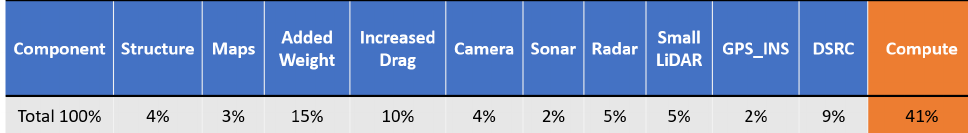
Figure 3. Power consumption rate of AI chip for Ford Fusion’s autonomy